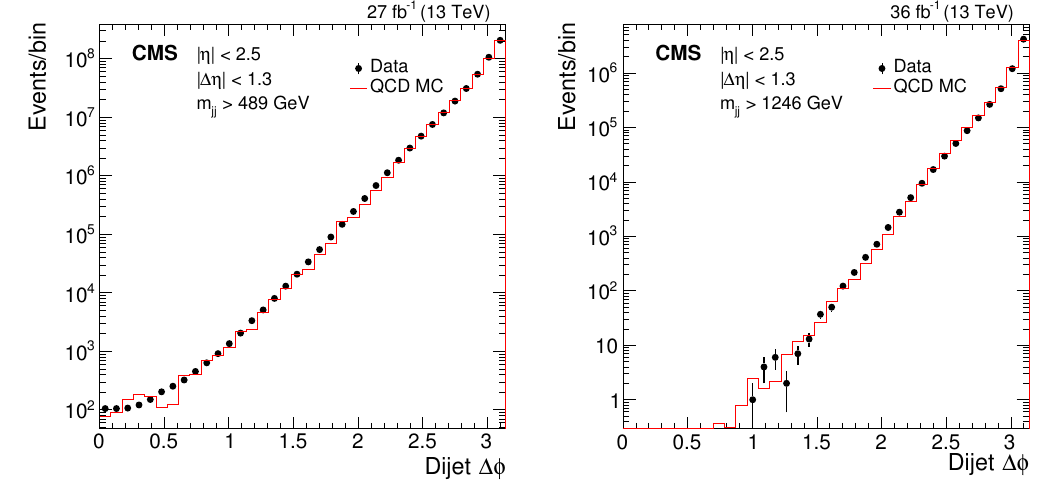
Figure 3 . The azimuthal angular separation between the two wide jets (in radians) from the low- mass search (left) and the high-mass search (right). Data (points) are compared to QCD predictions from the pythia 8 MC including detector simulation (histogram) normalized to the data.